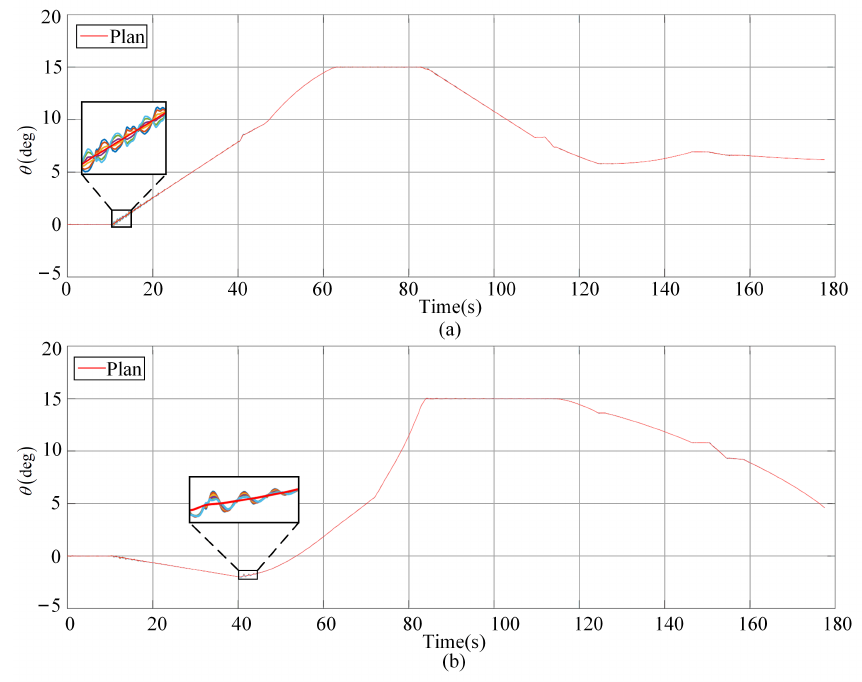
Figure 14. The comparison between the planning curve and the simulation curve of the six cross-axis joints of the 3rd segment. ( a ) Alpha direction. ( b ) Beta